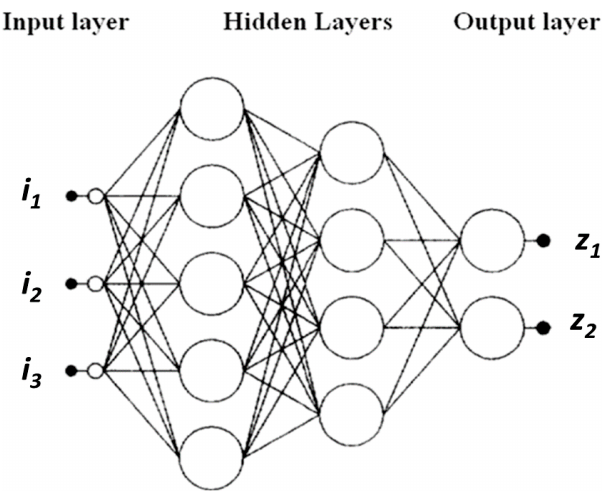
Figure 7. A single processing unit in neural networks.